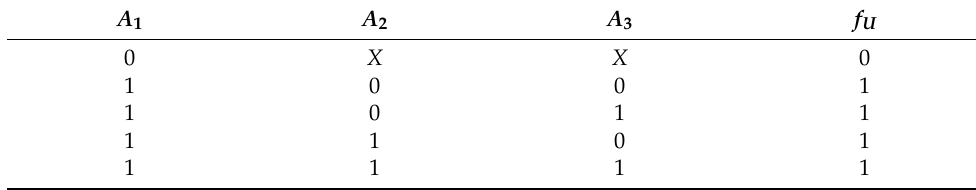
Table 10. Boolean relations for three